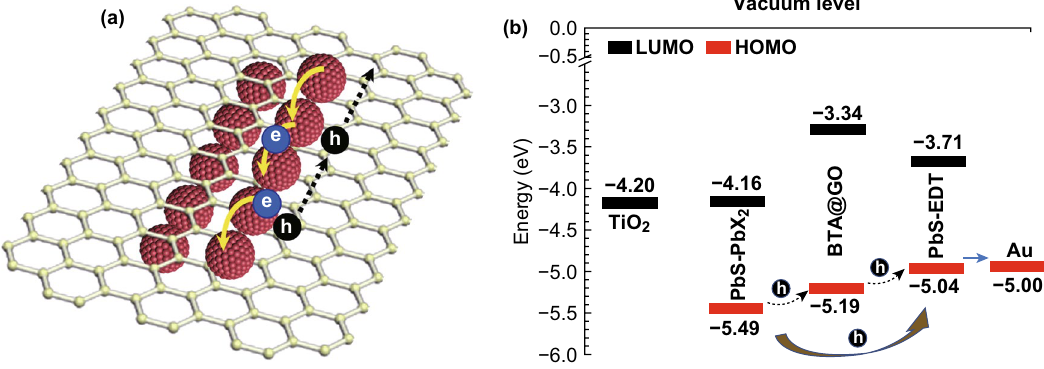
Fig. 2 a Schematic diagram of the charge transport process in the BTA@GO/PbS-PbX 2 hybrid CQDs film. b Schematic energy level diagram of the TiO 2 , PbS-PbX 2 CQDs, BTA@GO, PbS-EDT CQDs, and